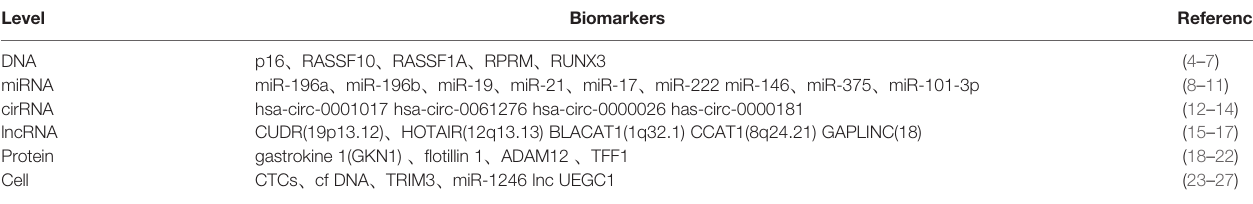
TABLE 1 | A brief summary of potential biomarkers for early diagnosis of gastric